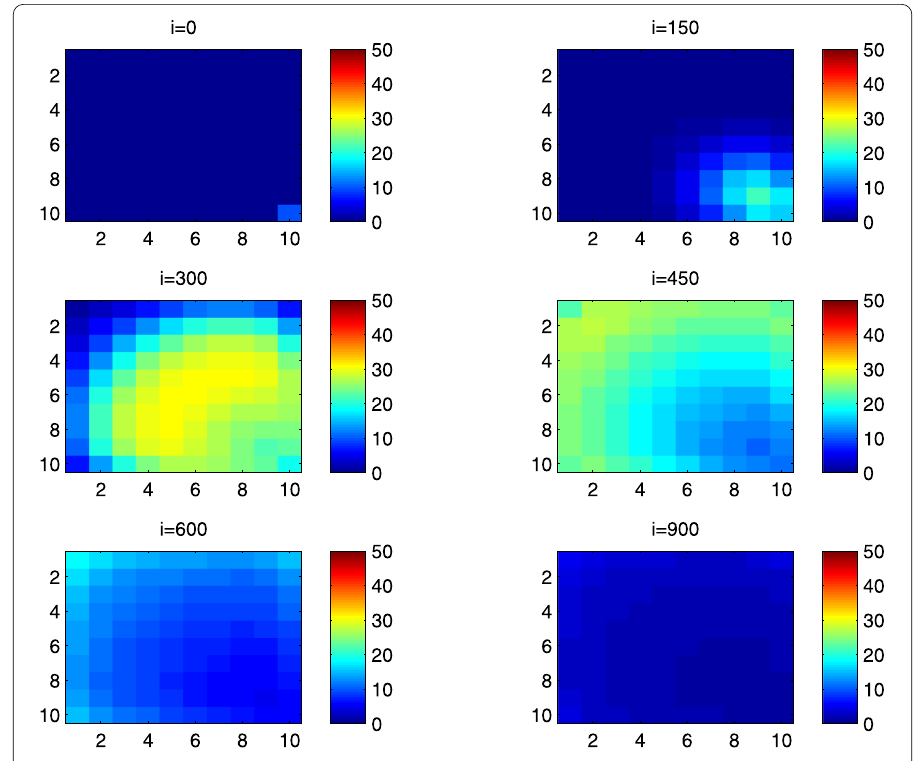
Figure 4 I Cpq behavior in the absence of control. The case when the disease starts from the corner C 11 .